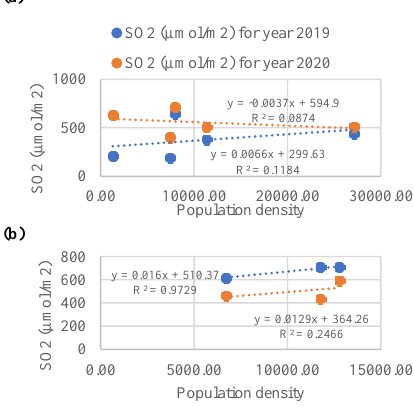
Figure 10. Influence of population density on SO 2